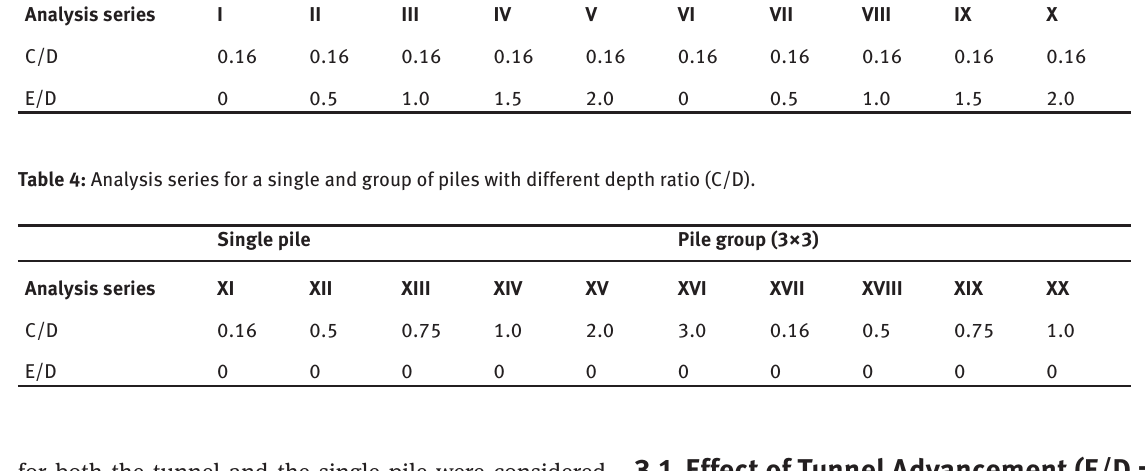
Table 3: Analysis series for a single and group of piles with different offset ratio (E/D) Single pile Pile group (3×3) Analysis series